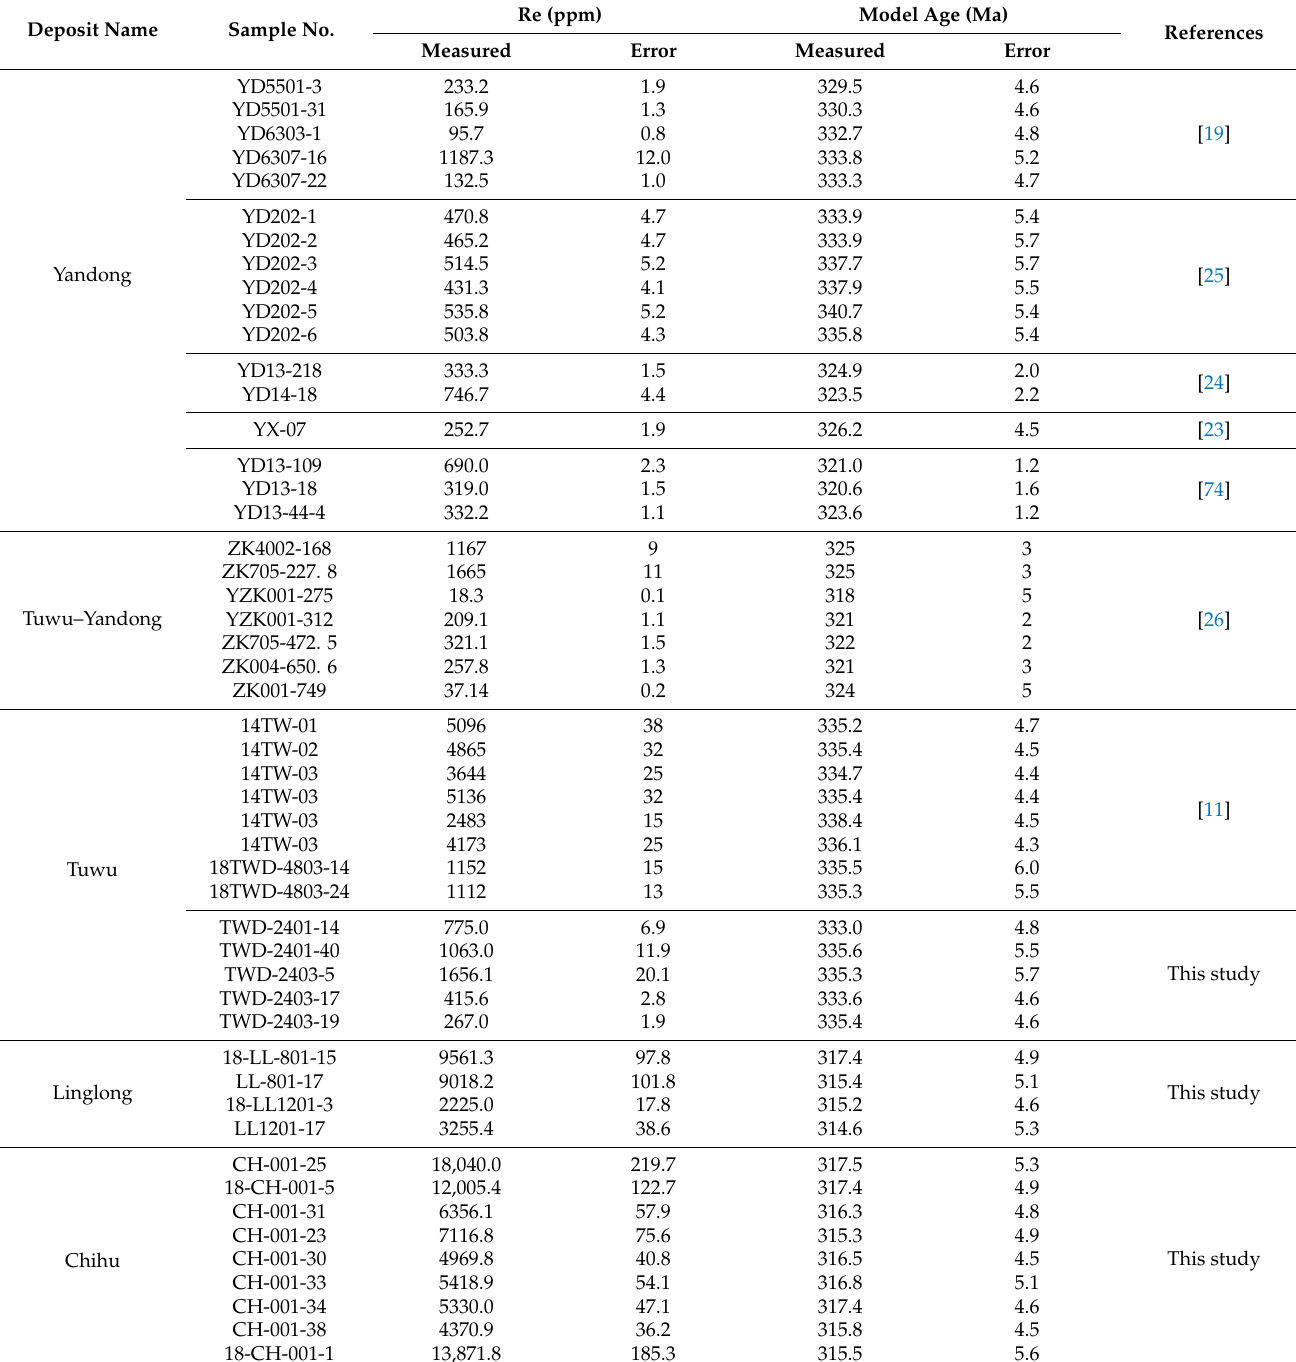
Table 4. Summary of Re contents and model ages of molybdenite from the Tuwu porphyry Cu belt in Eastern Tianshan, NW